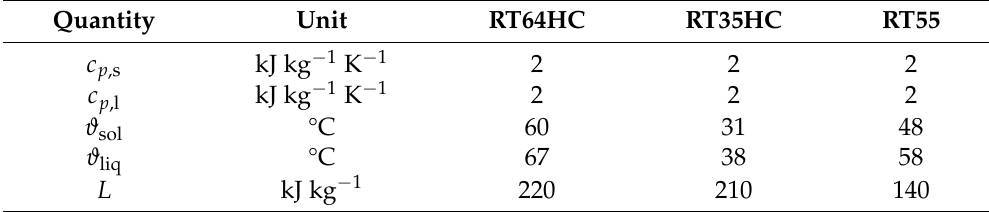
Table 1. Physical properties of phase change